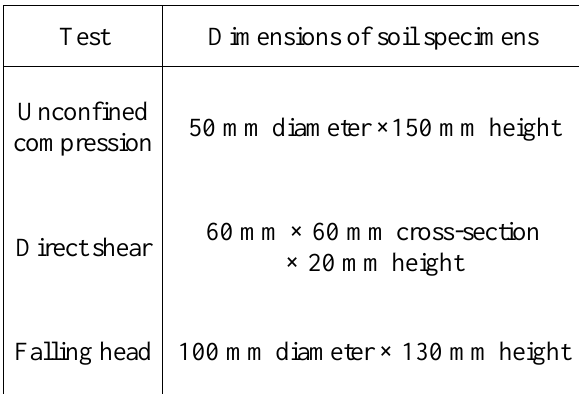
Table 3. Sizes of soil specimens for unconfined compression, direct shear and falling head permeability